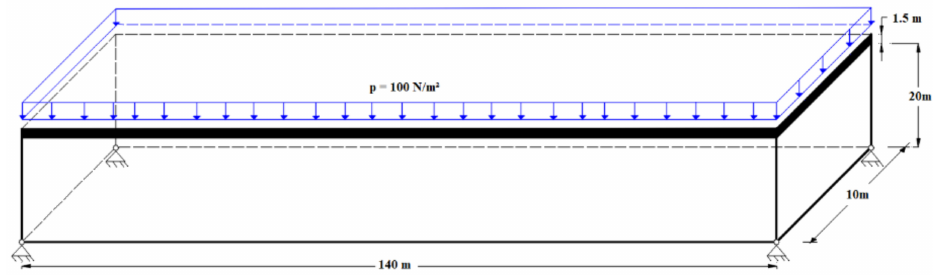
Figure 14. Design domain, loading and boundary conditions for a bridge, where the solid section denotes the non-designable